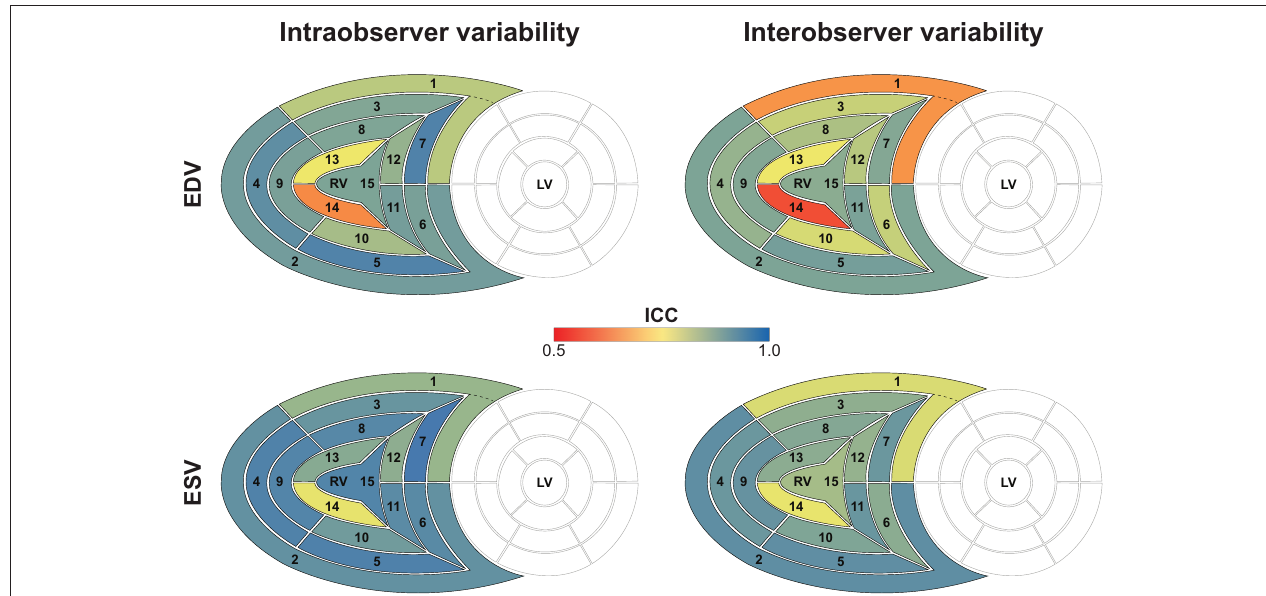
FIGURE 6 | Intra- and interobserver variability of right ventricular end-diastolic and end-systolic segmental volumes. The 15 segments are color-coded based on the value of the intraclass correlation coefficient: reddish colors indicate a lower, whereas blueish colors correspond to a higher value of intraclass correlation coefficient in the given segment. Segment numbers as defined in Figure 3 . EDV, end-diastolic volume; ESV, end-systolic volume; ICC, intraclass correlation coefficient; LV, left ventricle; RV, right ventricle.